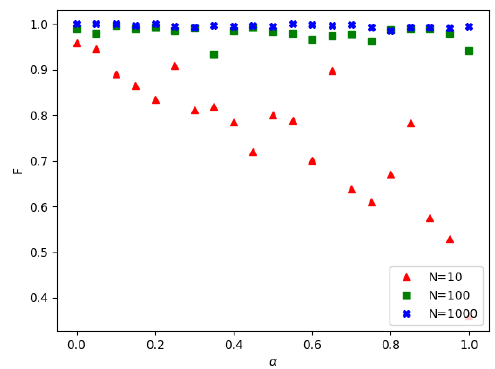
Figure 1. Comparison of fidelity when σ =